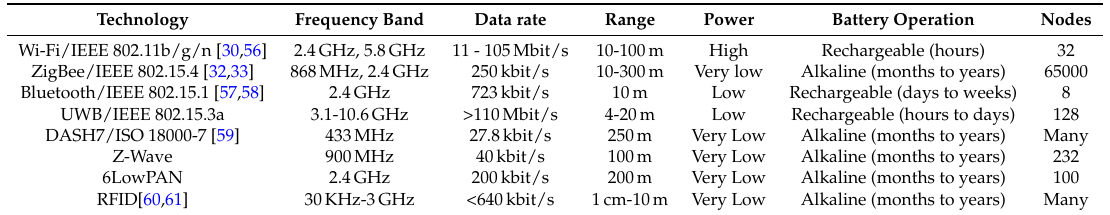
Table 3. Wireless communications technologies proposed for monitoring